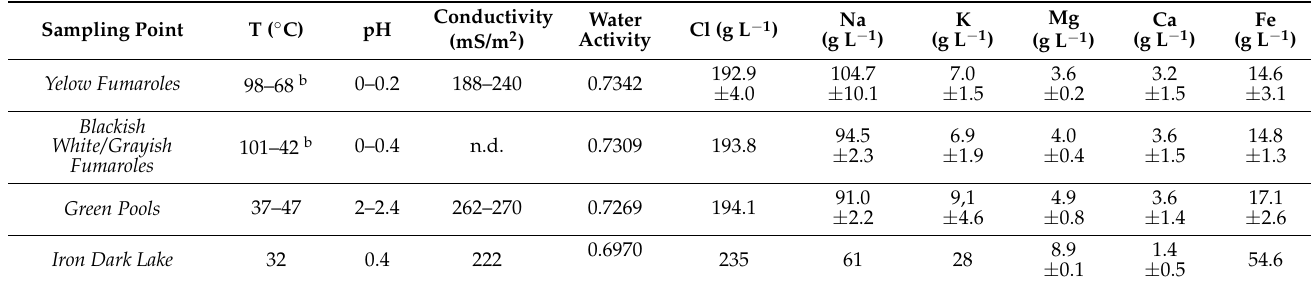
Table 1. Physicochemical characteristics of different sampling points a